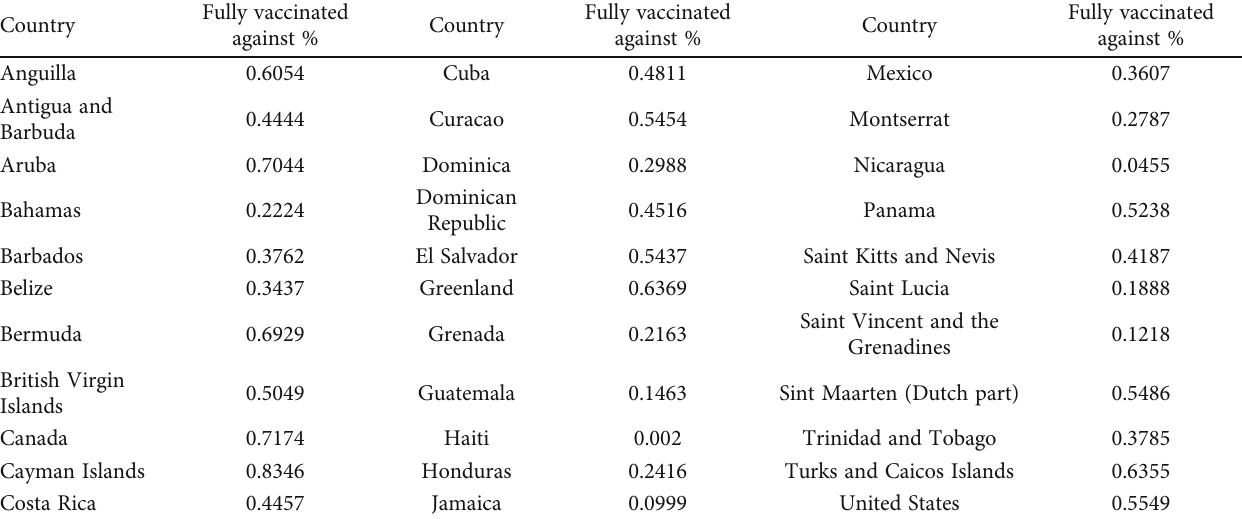
Table 1: In North American countries, the percentage of people who have been fully immunized against COVID-19. Country